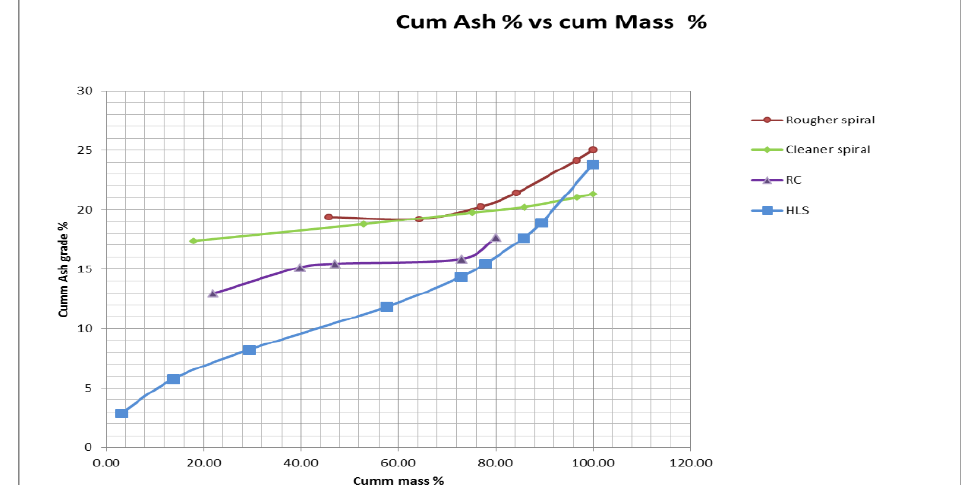
Figure 3. Cumulative ash % vs Cumulative mass % curve for the methods used